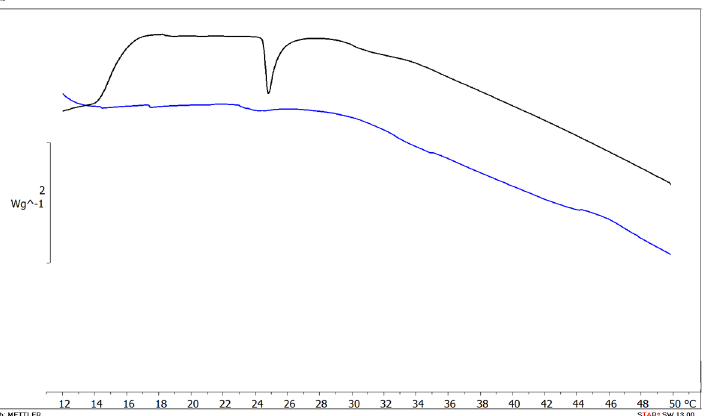
Figure 6. DSC thermograms of empty multilamellar (MLV) structures (black curve) and MLV with Cur 5 µ M (blue